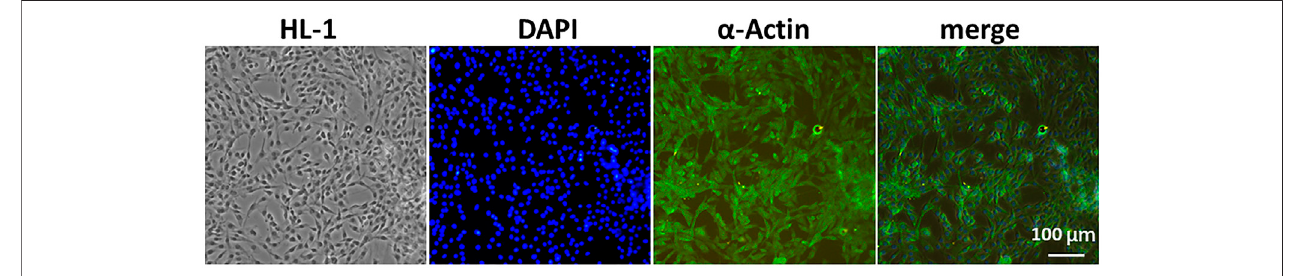
FIGURE 4 | CytotoxicitytestofCQand ultrasound-assisteddrugrelease. (A,B) HL-1cellswereincubated withamedium containing0,10,20, 40,60,80,and 100 μ g/ml CQfor24htodetectthecellviabilityandobservethecellsurvivalstateunderamicroscope.WhentheconcentrationofCQwas60 – 100 μ g/ml,HL-1hadobviouscytotoxicity(VS. “ 0-µg/mlgroup, ” * p < 0.05,*** p < 0.001, n =5,Bar=50µm).WhentheconcentrationofCQwas60 μ g/ml,theviabilityofHL-1cellswas87.9%±7.73%. (C) ThemaximumUV absorption peak of CQ detected using a UV spectrophotometer was 322 nm. The release of CQ in 100 μ l CQ/PLGA suspension was detected after continuous action of differentultrasonicintensitiesfor60s.Whentheultrasoundintensitywas100 – 130mvpp,CQ/PLGAwastriggeredtoreleaseCQ(vs. “ 0-mvppgroup, ” * p < 0.05,** p < 0.01, n =5). (D) When the ultrasound intensity was 100 mvpp, the shape changes in CQ/PLGA before and after ultrasound were observed using a SEM after continuous action for 60 s.